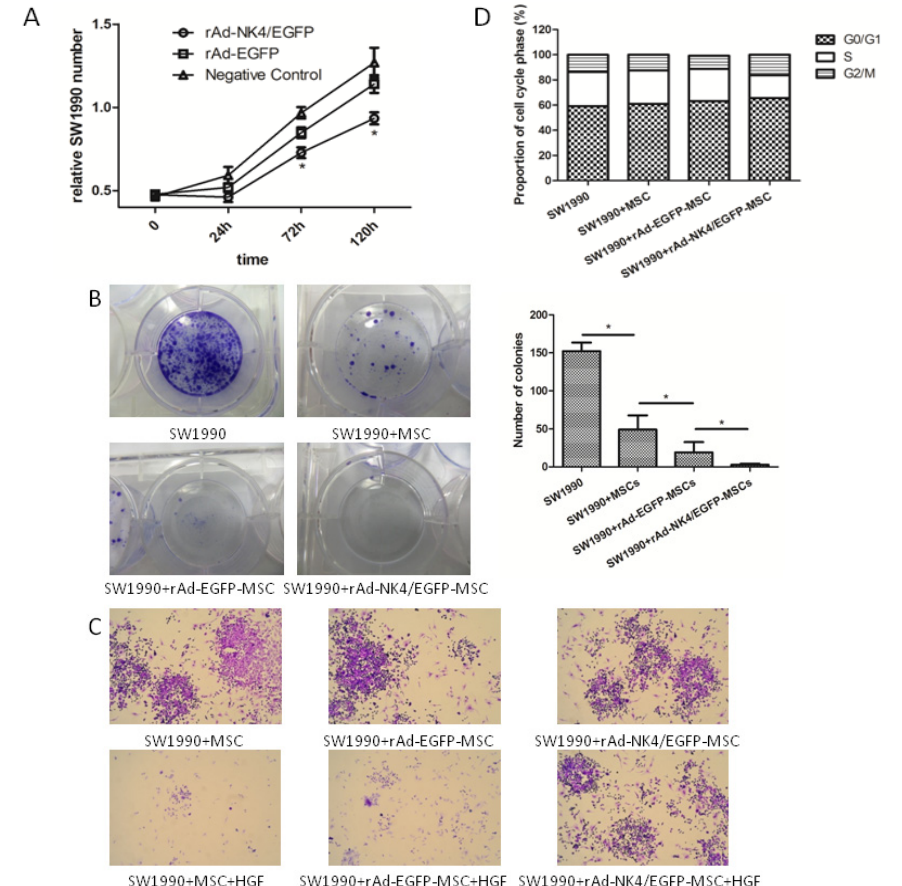
Figure 5. Effect of transfected MSCs on the biological characteristics of pancreatic cancer cells. ( A ) Effect of transfected MSCs on SW1990 cell proliferation. Fewer SW1990 cells grew in the rAd- NK4 /EGFP MSCs group on the fifth day compared with the rAd-EGFP MSCs group and control. Cell proliferation of different groups was evaluated by MTT assay. * p < 0.05. The data are presented as mean ± SD of six samples; ( B ) Effect of transfected MSCs on SW1990 cell colony formation and colony-forming ability of rAd- NK4 /EGFP MSCs on SW1990 cells. SW1990 cells, MSCs, rAd-EGFP MSCs and rAd- NK4 /EGFP MSCs were grown in 1640 Medium for 21 days and fed with media every two days. The colonies formed in the medium were stained with 5% Giemsa and observed. Magnified views of selected colonies are shown on the bottom panel. Number of colonies grown in medium were counted under the light microscope and plotted. Bars represent standard deviation ( n = 3, * p < 0.05); ( C ) Effect of transfected MSCs on SW1990 cell scatter. Cells were treated for 48 h by HGF/SF (10 μ g/L) to induce cell scattering. rAd- NK4 /EGFP MSCs inhibit SW1990 cells scatter significantly after 48 h compared with the control group. The SW1990 cells were stained as purple while the MSCs were stained as black; ( D ) Effect of transfected MSCs on SW1990 cell cycle. Flow cytometric analysis was used to determine the alterations in the cell cycle distributions in SW1990 cell lines following the administration of MSCs, rAd-EGFP MSCs and rAd- NK4 /EGFP MSCs. The data are presented as mean ± SD of triplicate samples. * p < 0.05 rAd- NK4 /EGFP group compared with the rAd-EGFP group and control